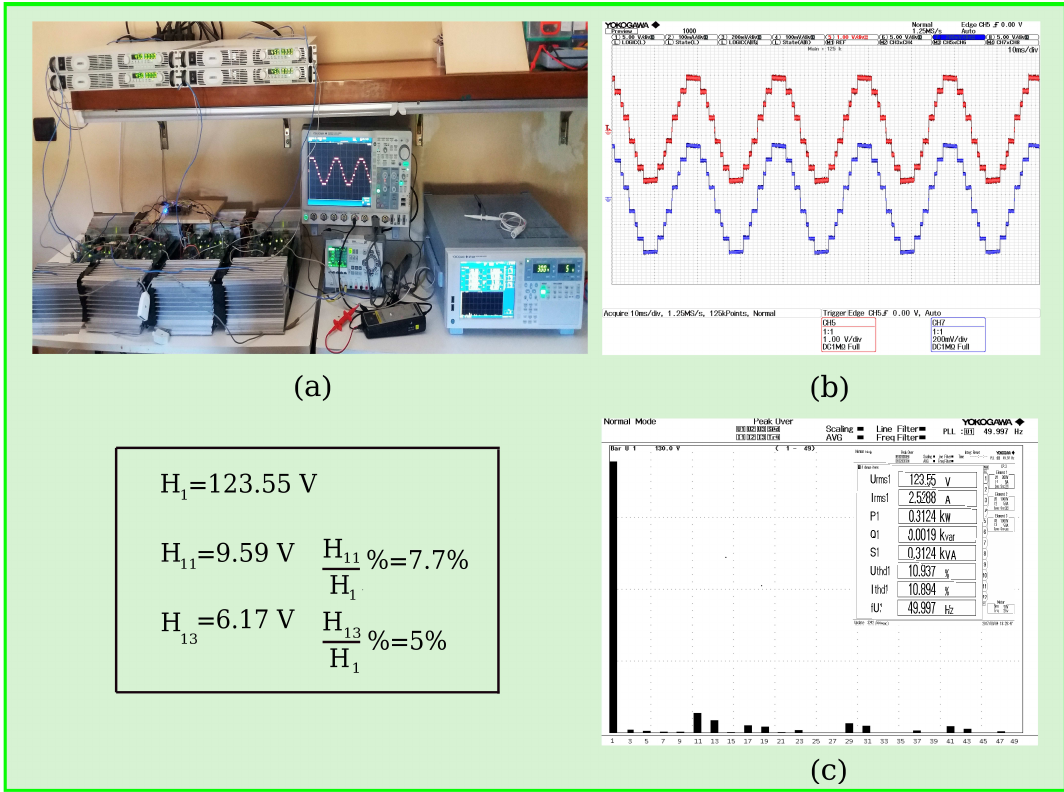
Figure 10. Measurements: ( a ) experimental prototype of single-phase CHB 9-level inverter, ( b ) output voltage and current waveforms, ( c ) harmonic analysis of the output voltage waveform (130 V,